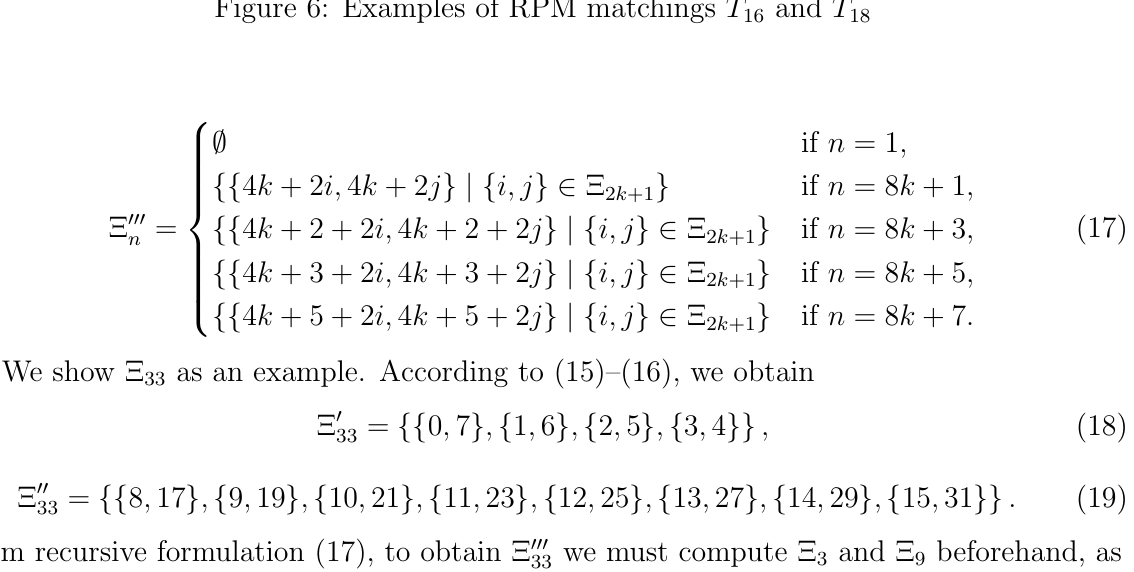
Figure 6: Examples of RPM matchings T